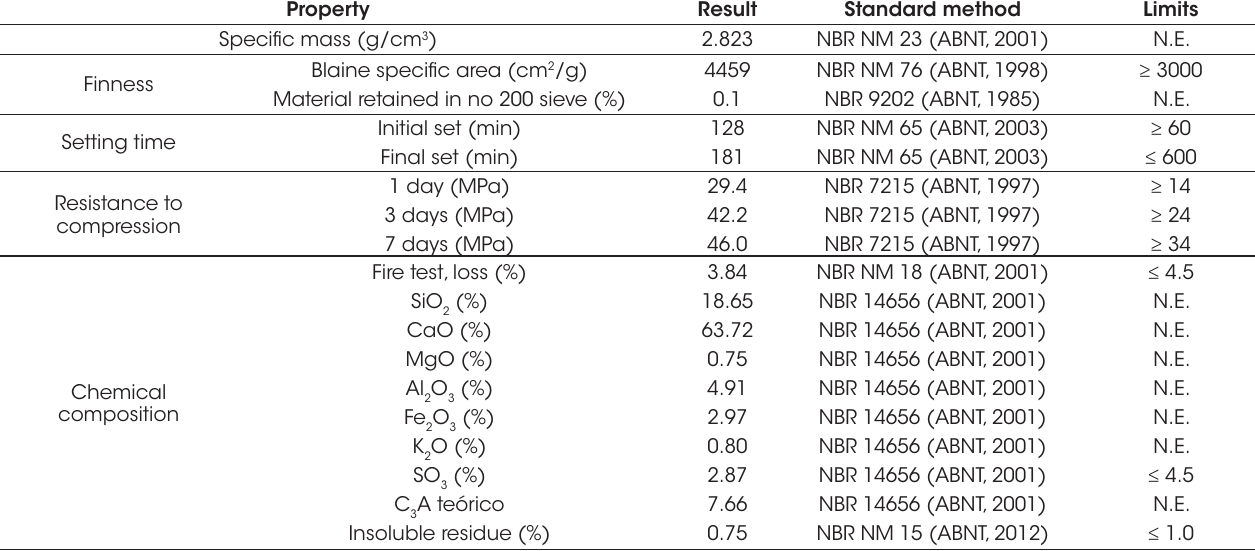
Physical and chemical characterization of Portland Cement type CP V ARI Property Result